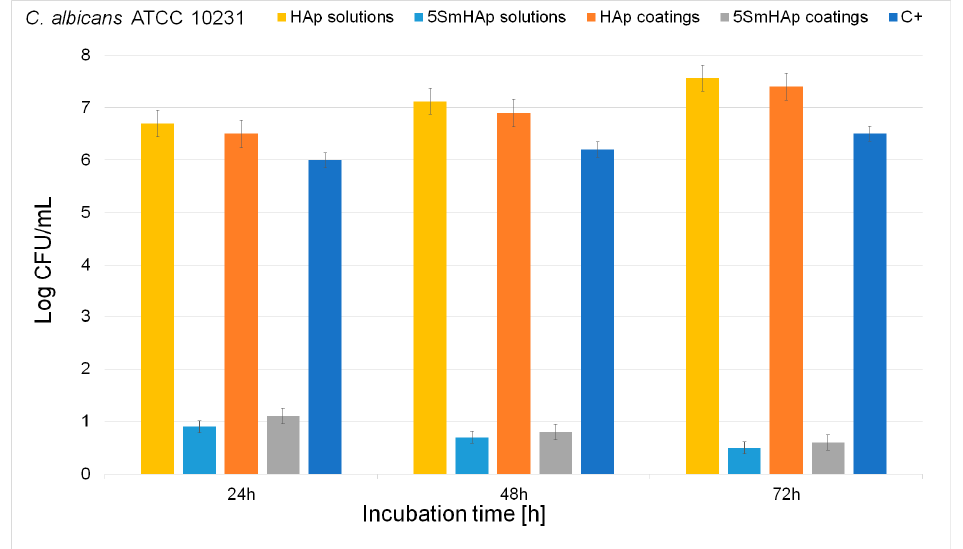
Figure 17. Graphical representation of the Log colony forming units (CFU)/mL of C. albicans as a function of time of exposure to the HAp and 5SmHAp suspensions and coatings.